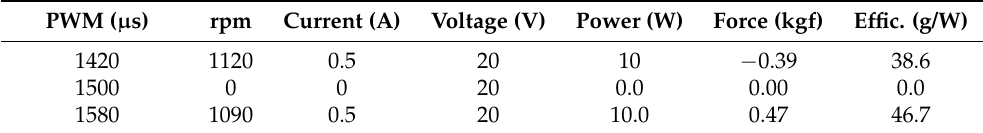
Figure 9. ( a ) Required torque in the active joint Q 1 ; ( b ) required torque in the active joint Q 2 . Table 4. Performance data for BlueRobotics motor